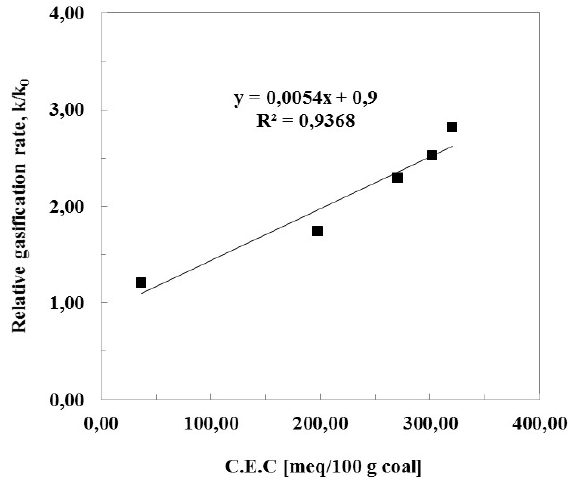
Figure 6: Correlation between the CEC and the relative specific hydrogasification rate at 850°C (catalyst: potassium carbonate, 20%